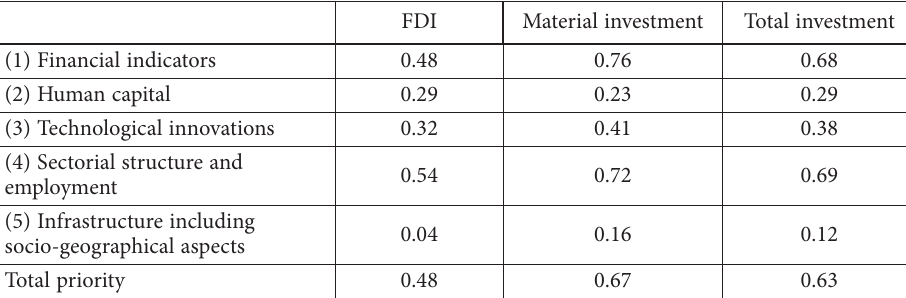
Table 4. The results of correlation of priorities for the Districts (made by authors) FDI Material investment Total